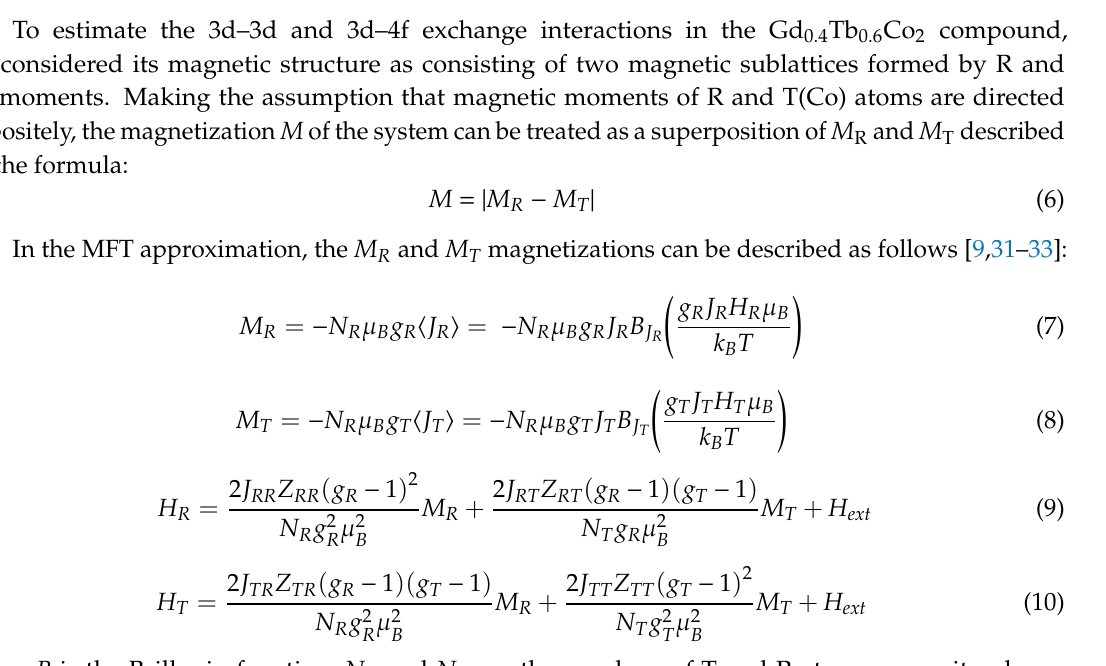
0.4 Tb 0.6 Co 2